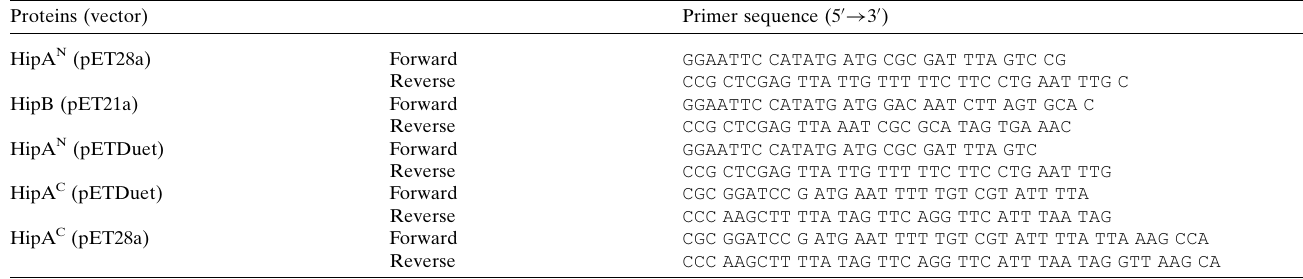
Table 1 Primers designed for cloning the genes encoding HipA N , HipA C and HipB. Proteins